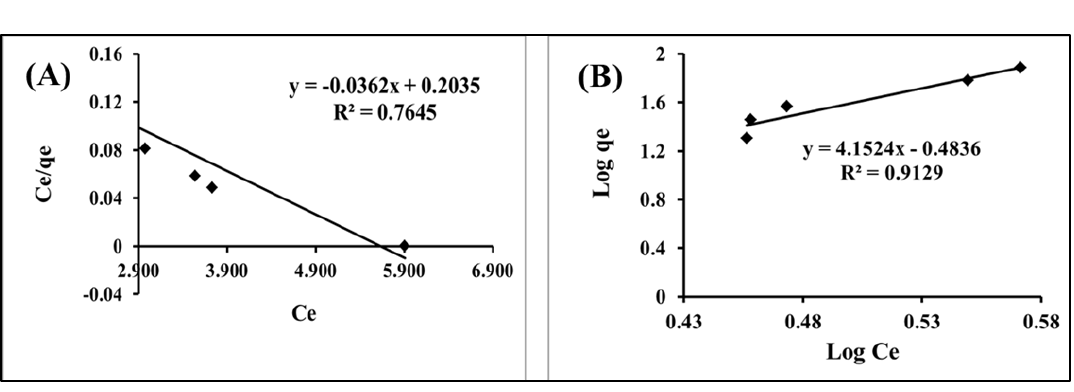
Table 2. Langmuir and Freundlich constants of Hg(II) ions on IL-ACMRW (ionic liquid modified activated carbon from mixed recyclable waste).